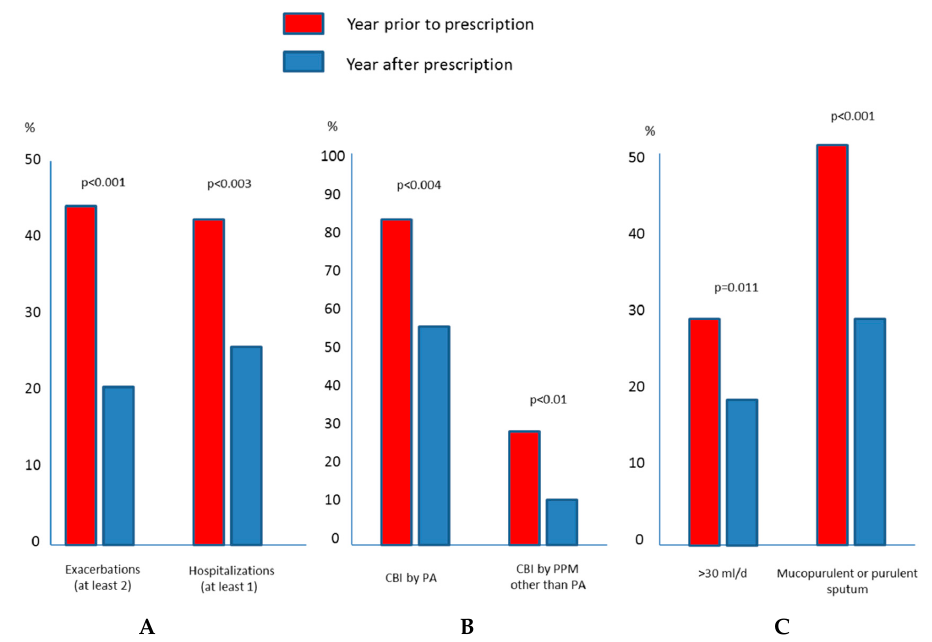
Figure 2. Clinical efficacy of dry powder antibiotics with respect to ( A ) exacerbations; ( B ) chronic bronchial infection and; ( C ) sputum characteristics.